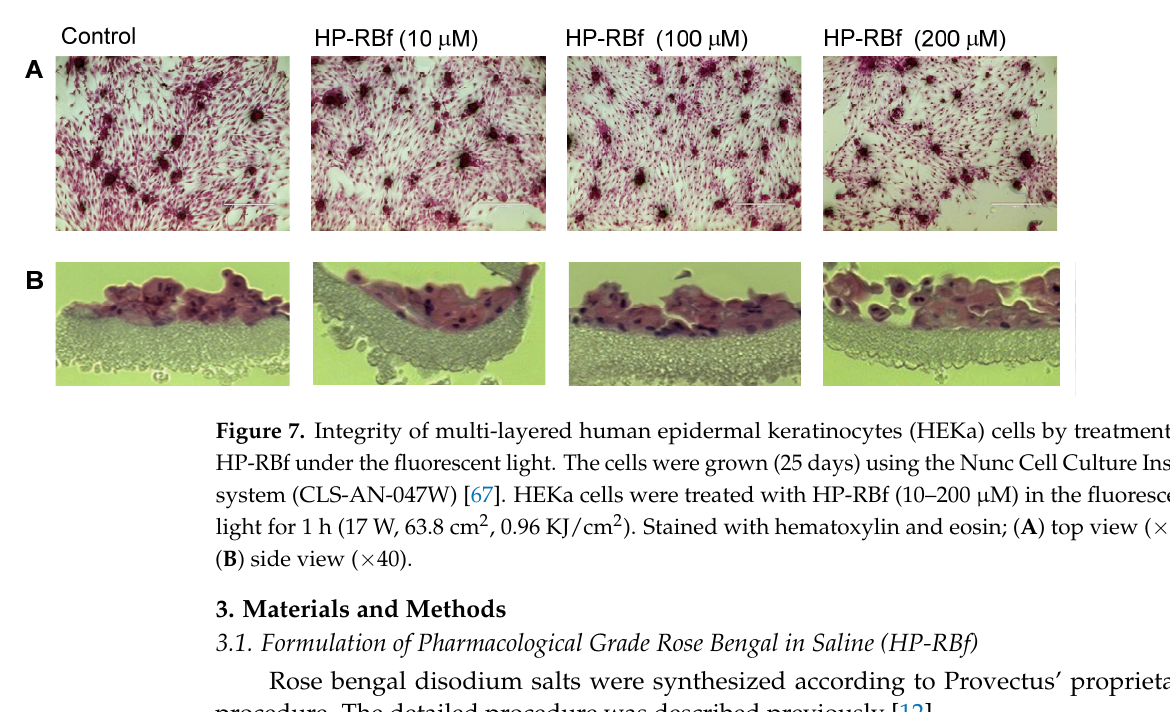
Figure 6. Cell confluence (%) vs. incubation time with HP-RBf in Vero cells under the fluorescent light (17 W, 63.8 cm 2 , 0–1.1 KJ/cm 2 ). a